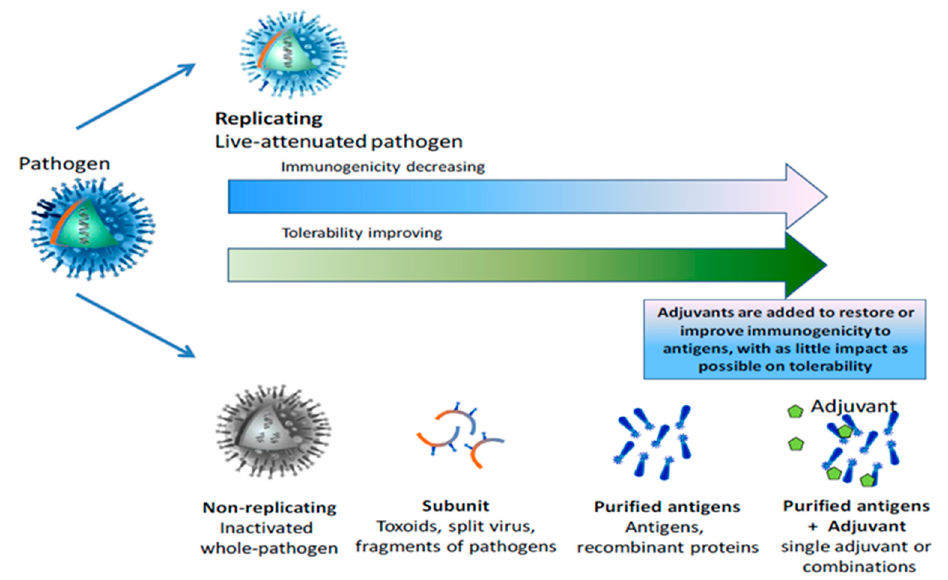
Figure 1. Vaccine antigen type consequence on vaccine safety and immunogenicity.